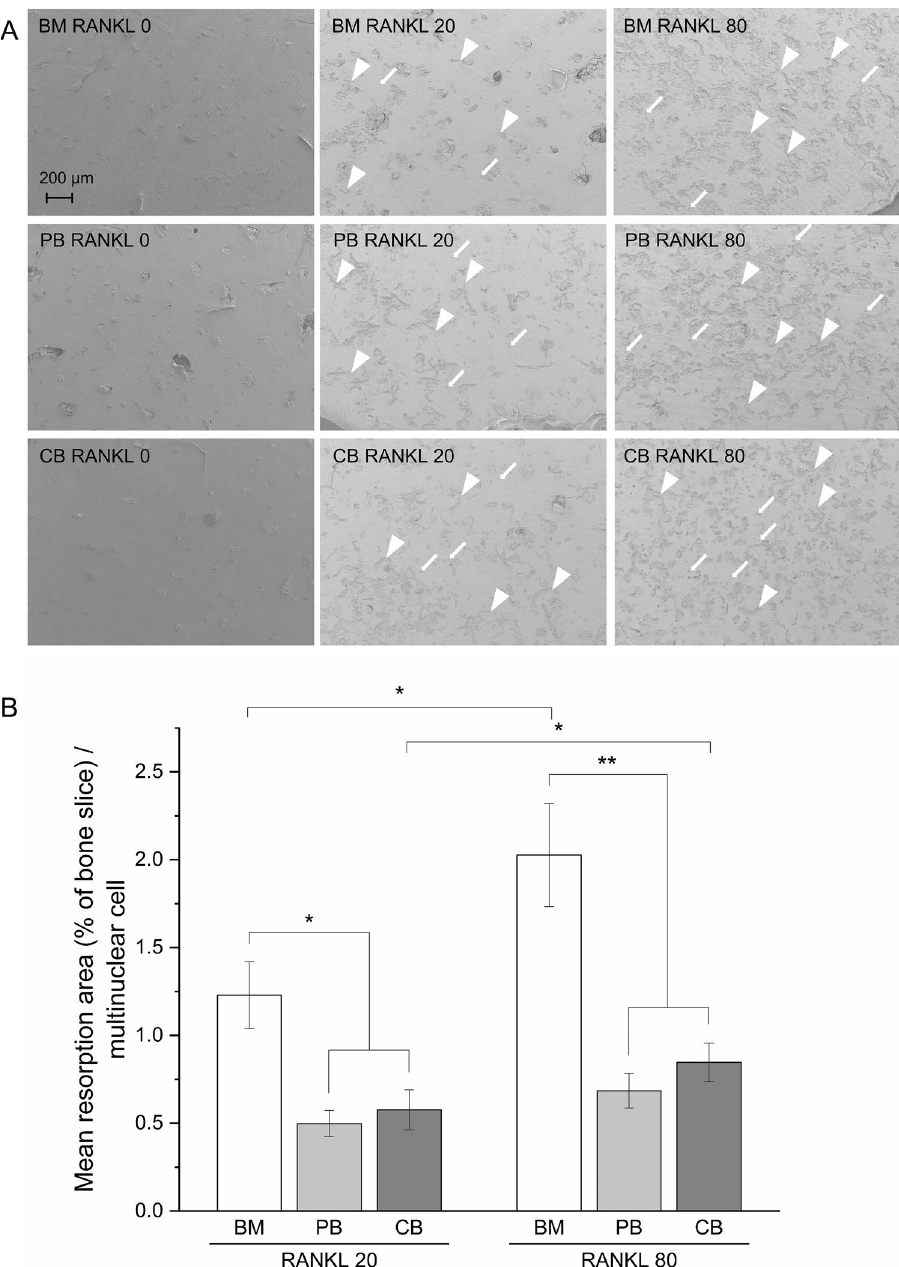
Figure 3. Bone resorption activity of osteoclasts differentiated from BM, PB and CB. ( A ) FESEM images of the bone slices on d14 were taken with 50 × magnification (representative data from one patient). Pit-like resorption pits are pointed with arrows and trench-like resorption pits with arrowheads. ( B ) Mean resorption pit areas measured from FESEM images on d14. The data in the graph is pooled from 4 patients per culture type and shown as mean ±